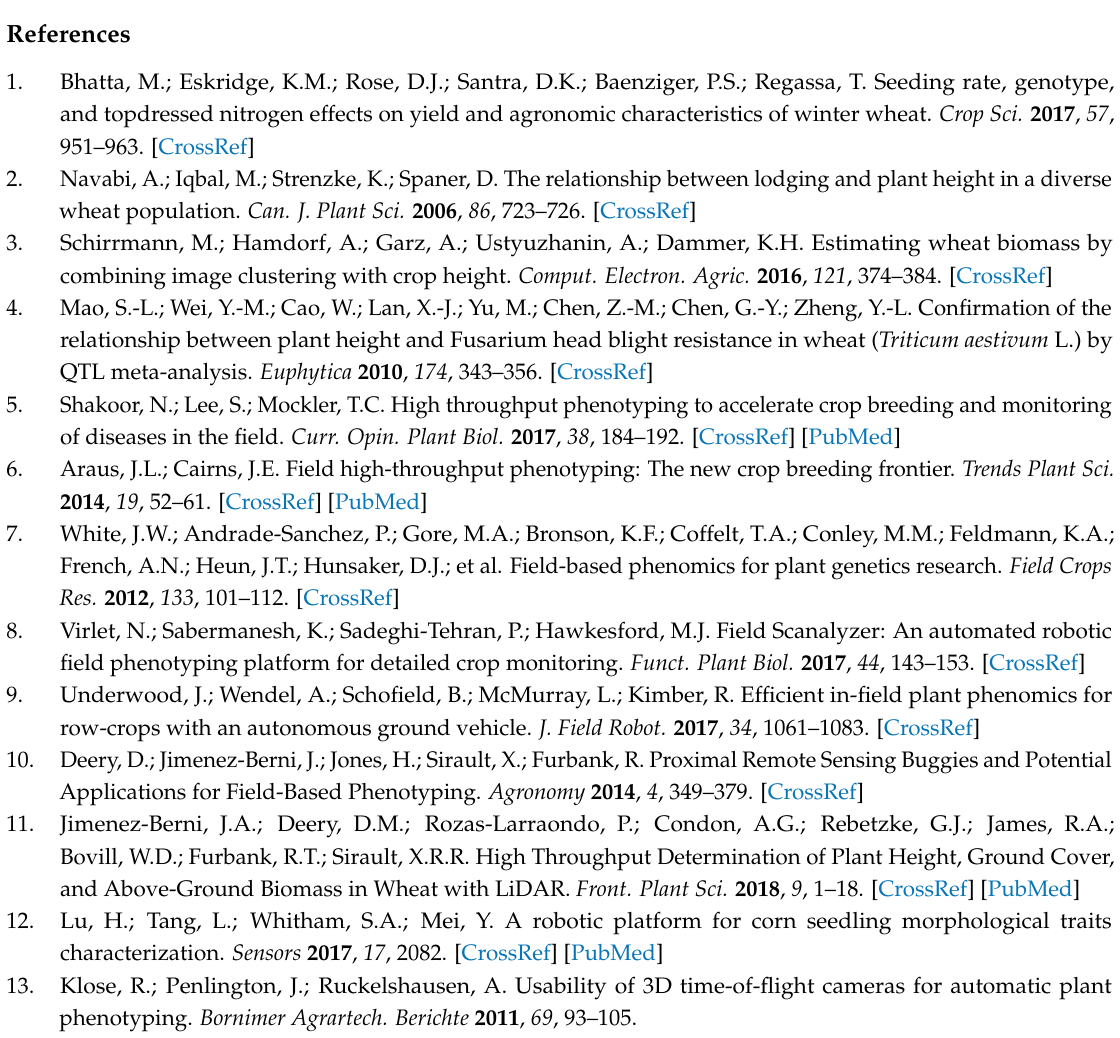
Figure A6. An example of splitting a point cloud: ( a ) point cloud of ground after rotation and shifting; ( b ) the mean in the X dimension for each side; ( c ) point cloud of each plot after splitting.